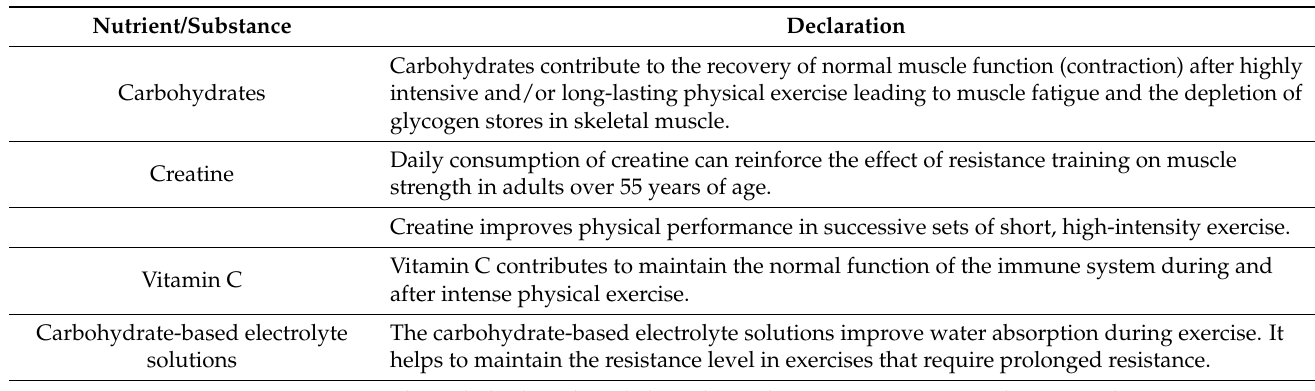
Table 2. Health claims related to physical